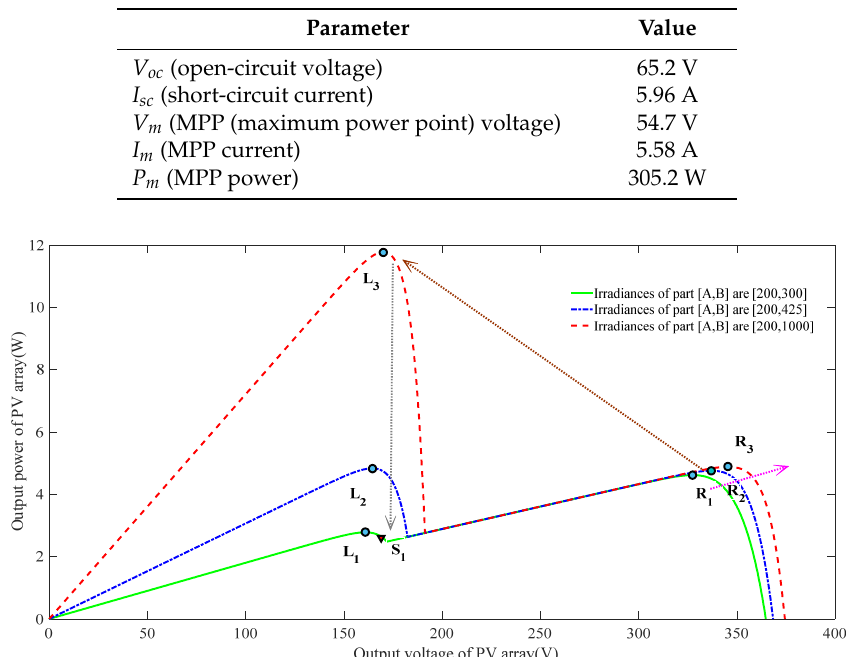
Table 1. Parameters of the solar cell.